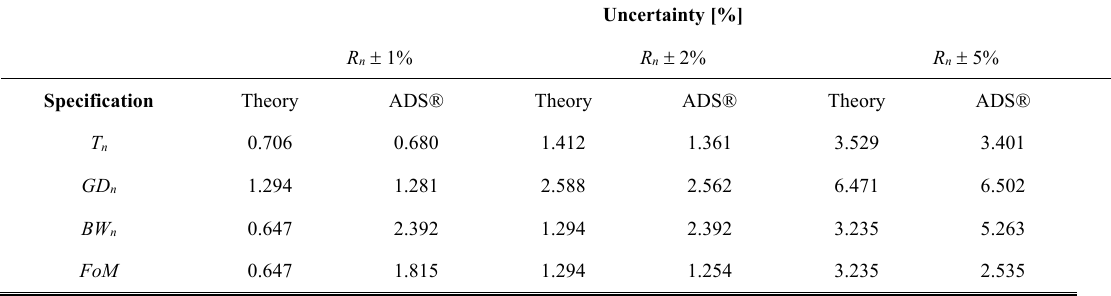
TABLE V. UAs of NGD specifications according to variations of R